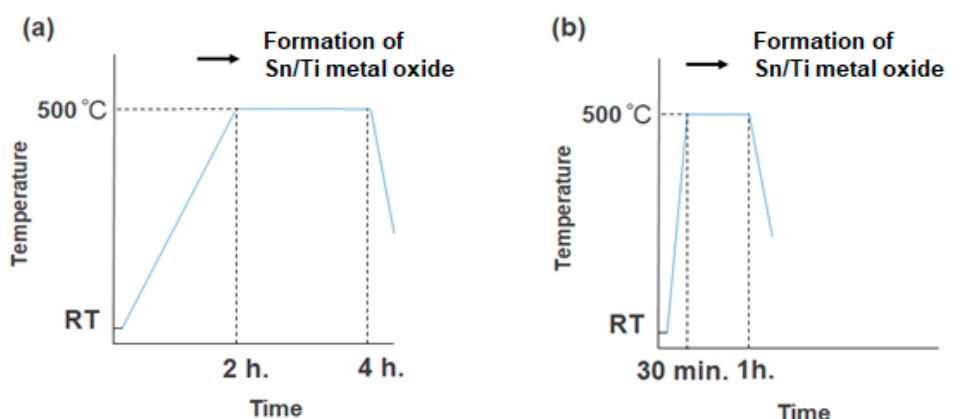
Figure 1. Sintering strategies of the Sn/Ti oxide thin-film samples in air. The periods of maximum temperature at 500 °C were 2 h for ( a ) and 30 min for ( b ), respectively. From 500 °C, the samples were cooled down to room temperature naturally.